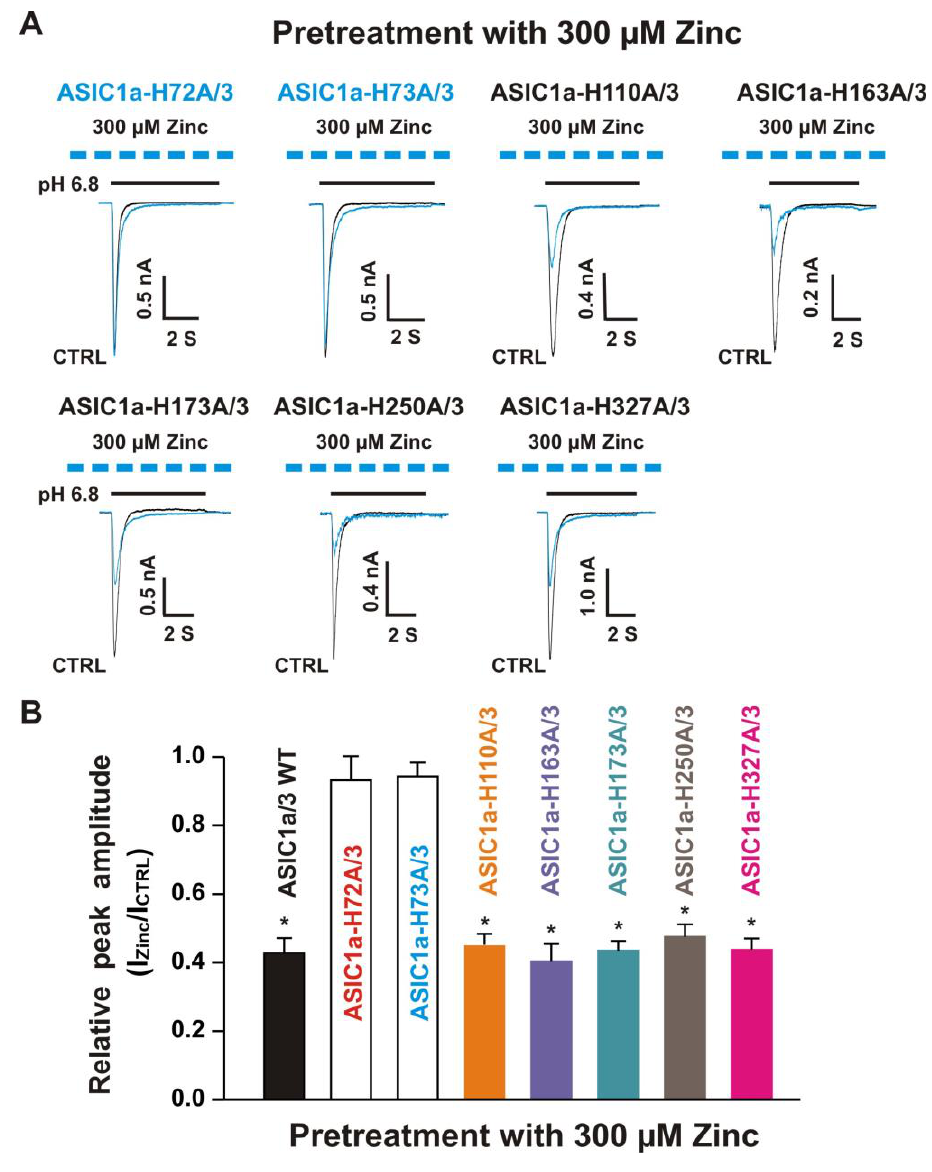
Figure 10. Effects by pretreatment with 300 µM zinc on currents recorded from ASIC1a histidine Figure 10. E ff ects by pretreatment with 300 µ M zinc on currents recorded from ASIC1a histidine mutant mutant co-expressed with ASIC3 WT on CHO cells. ( A ) Representative traces show that co-expressed with ASIC3 WT on CHO cells. ( A ) Representative traces show that pretreatment with pretreatment with zinc at a concentration of 300 µM inhibited the currents recorded from zinc at a concentration of 300 µ M inhibited the currents recorded from heteromeric ASIC1a-H110A / 3, heteromeric ASIC1a-H110A/3, ASIC1a-H163A/3, ASIC1a-H173A/3, ASIC1a-H250A/3, and ASIC1a- ASIC1a-H163A / 3, ASIC1a-H173A / 3, ASIC1a-H250A / 3, and ASIC1a-H327A / 3, but not ASIC1a-H72A / 3 H327A/3, but not ASIC1a-H72A/3 and ASIC1a-H73A/3. The dashed blue line represents and ASIC1a-H73A / 3. The dashed blue line represents pretreatment with 300 µ M zinc in the pH 7.4 pretreatment with 300 µM zinc in the pH 7.4 solution with a duration of 2 min; ( B ) Statistical bar solution with a duration of 2 min; ( B ) Statistical bar graphs show relative peak amplitude of the graphs show relative peak amplitude of the currents from ASIC1a/3 WTs and its histidine mutant/3 currents from ASIC1a / 3 WTs and its histidine mutant / 3 as mentioned above by pretreatment with as mentioned above by pretreatment with 300 µM zinc ( n = 7 to 15). Pretreatment with or without 300 µ M zinc ( n = 7 to 15). Pretreatment with or without 300 µ M zinc did not a ff ect the peak amplitude of the currents recorded from ASIC1a-H72A / 3 and ASIC1a-H73A / 3 ( p > 0.05, t-test). There was no significant di ff erence for zinc inhibition among ASIC1a / 3 WTs, ASIC1a-H110A / 3, ASIC1a-H163A / 3, ASIC1a-H173A / 3, ASIC1a-H250A / 3, and ASIC1a-H327A / 3 ( p > 0.05, ANOVA). Whole-cell patch-clap recording was performed and currents from heteromeric ASIC1a / 3 WTs and ASIC1a histidine mutant co-expressed with ASIC3 on CHO cells were triggered by a drop in pH from 7.4 to 6.8. Data are presented as mean ± SEM. CTRL, control; I CTRL , ASIC current without any treatment; I Zinc , ASIC current by zinc treatment. * p < 0.05 ( t